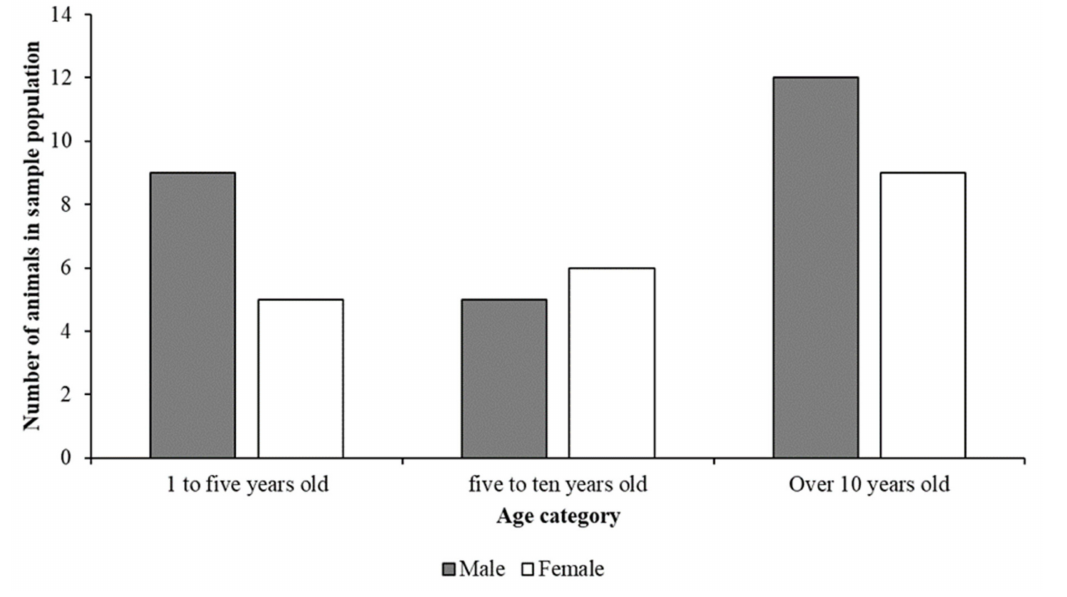
Figure 1. Age categories of each fossa included in the